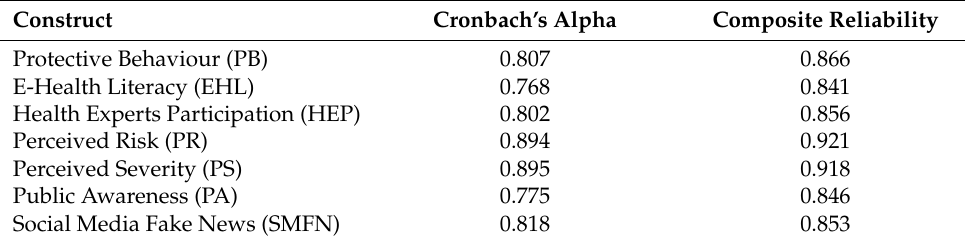
Table 3. Construct